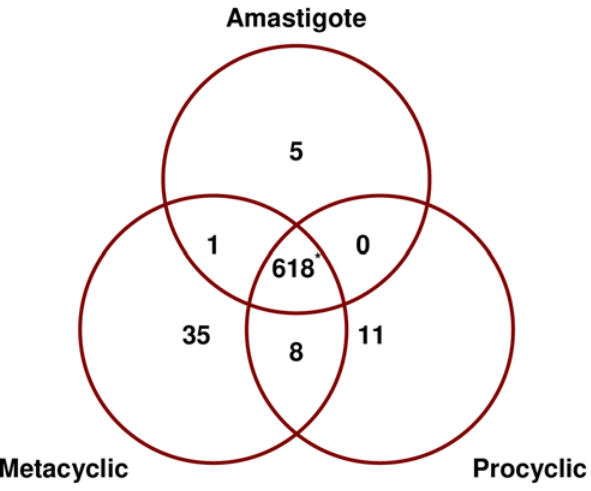
Figure 2. Distribution of genes preferentially expressed in one or more stages of L.braziliensis . Venn diagram showing distribution of upregulated genes ( . 1.7 fold, p , 0.05) in stages of the L. braziliensis life cycle. 8.8% (60/678) of the genes probed are regulated in their expression by these criteria, with 58% of these showing increased expression during the metacyclic stage. *Genes that are not differen- tially expressed between these stages.